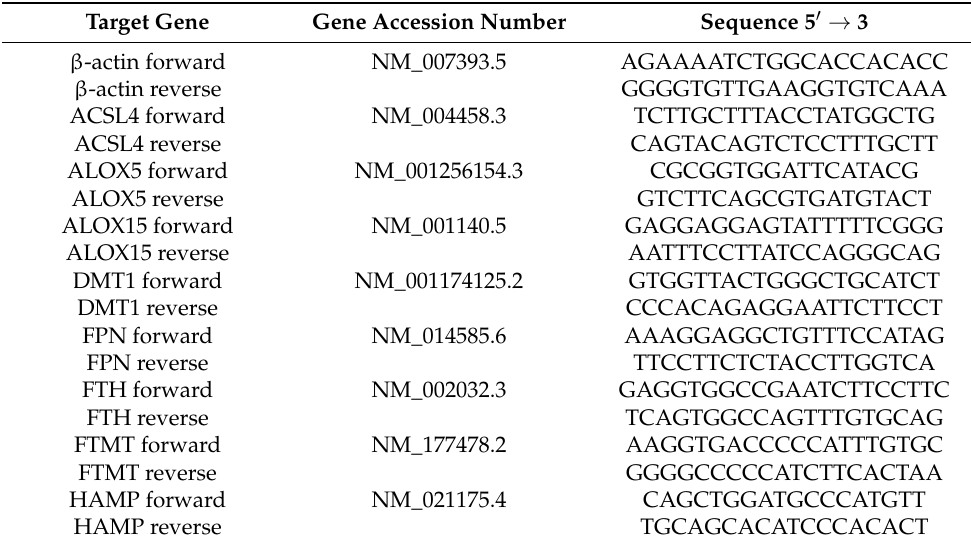
Table 2. Real-time PCR gene primer sequence